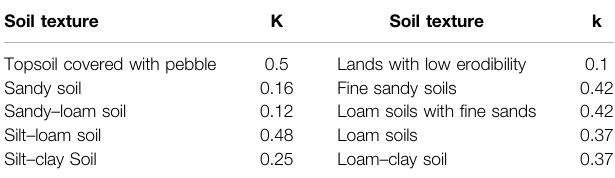
TABLE 2 | Erodibility coef fi cient (k) for different soil textures (Morgan and Nalepa,